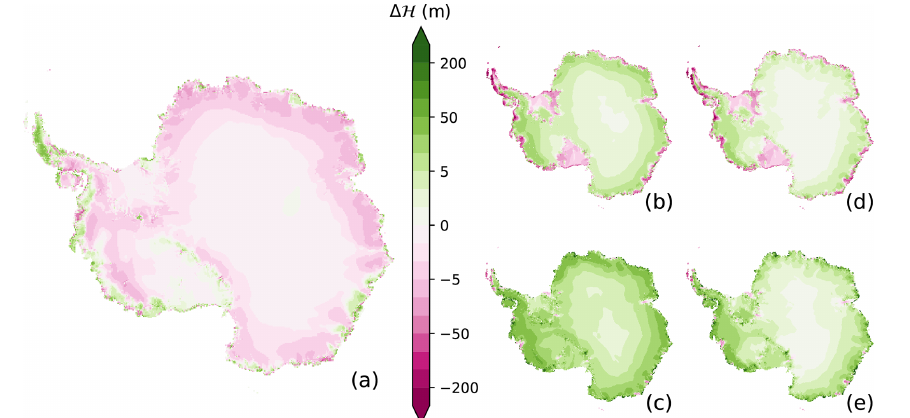
Figure 7. Ice thickness changes under the RCP8.5 scenario in the year 2100 since the year 1850. The ensemble mean difference between the runs forced by the scaled precipitation and the precipitation anomalies (a) . For each climate model scenario, the anomalies are computed relative to the 50 years of the related piControl scenario. The simulations driven with the precipitation anomaly (b, c) have the mean ice thickness (b) , and the maximum ice thickness (c) changes. The temperature-scaled precipitation of 5%K − 1 gives the corresponding ensemble mean (d) and maximum (e) . Please note that all subplots share the same color bar, and panel (a) equals panel (d) minus panel (b) .